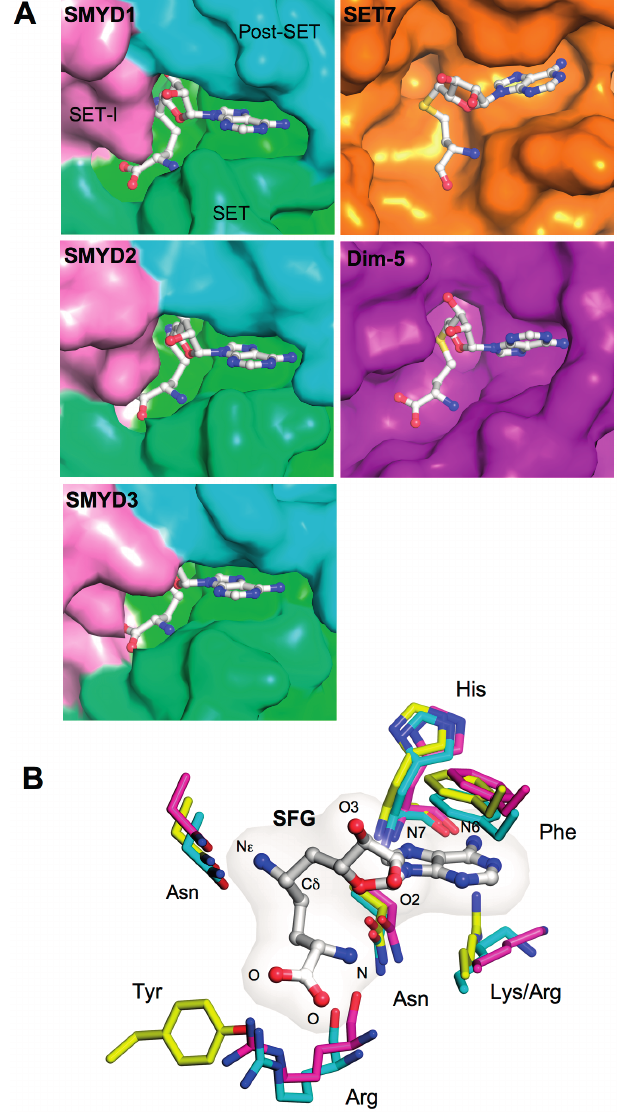
Figure 3. Cofactor binding pocket. ( A ) Surface representation of the cofactor-binding pocket of SMYD1–3, SET7 (PDB code: 1O9S), and Dim-5 (PDB code: